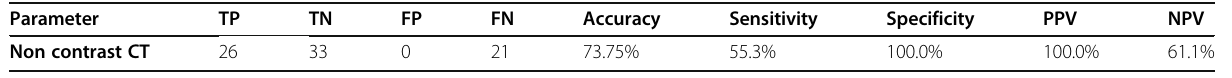
Table 3 Diagnostic accuracy of non-contrast CT chest in detection of central pulmonary embolism in our study Parameter